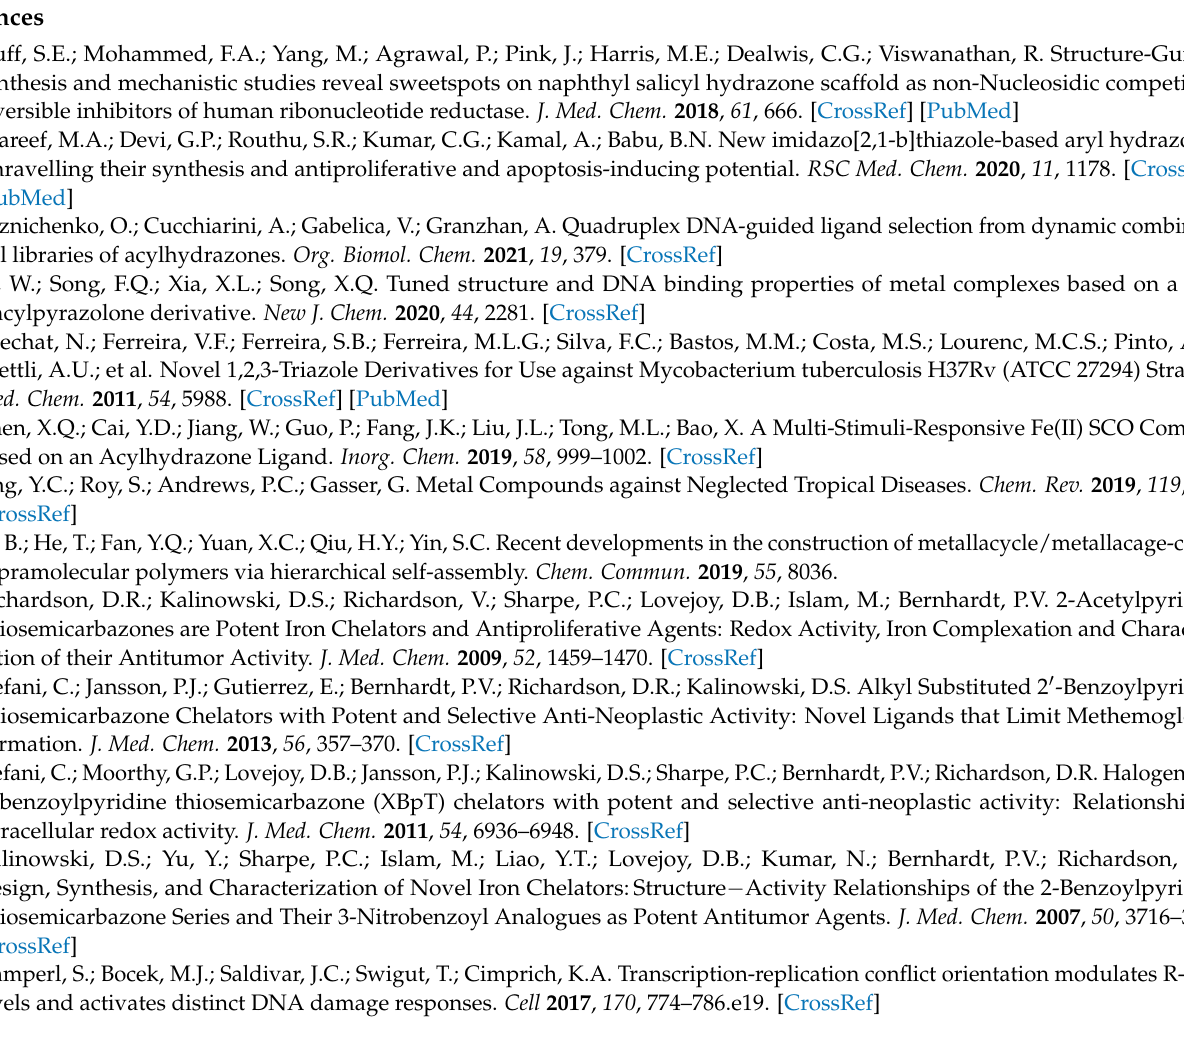
compound 3a to 3j . Table S1: Crystal data and structure refinement for the compound 3a – 3c . Table S2: Crystal data and structure refinement for the compound 3e – 3g . Table S3: Crystal data and structure refinement for the compound 3h – 3k . Table S4: Hydrogen bond parameters [Å and ◦ ] in the crystal structure of compounds 3a – 3j